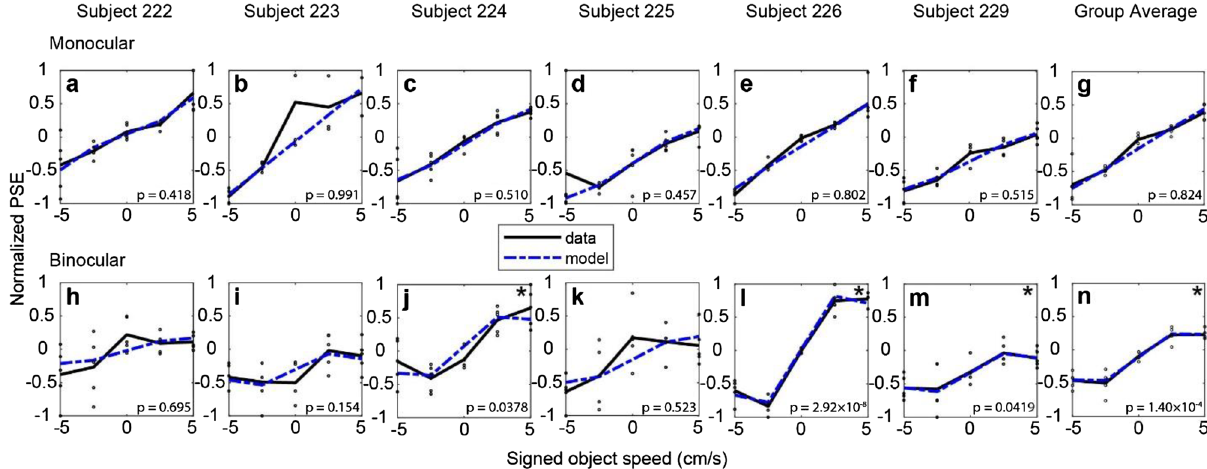
Figure 8. Quantifying the relationship between normalized depth PSEs and signed object speed. ( a – f ) Normalized depth PSEs are plotted against SOS for each subject tested in the monocular condition. Each data point (black) represents the normalized PSE calculated by fitting a psychometric function to data from each block of trials (see “Methods”). Best-fit regression models are shown for each subject (dotted blue curves). ( g ) Group average data and associated fit for the monocular condition; format as in panel ( a ). ( h – m ) Normalized PSE values are plotted against SOS for the binocular condition (black symbols), along with best fits of the regression model (dashed blue). ( n ) Group average data and associated fit for the binocular condition. The p value shown in each panel indicates the significance of the SOS 3 term in the model fit, which reflects the deviations from linearity. Significance of the SOS 3 term is indicated by an * in the upper-right corner of